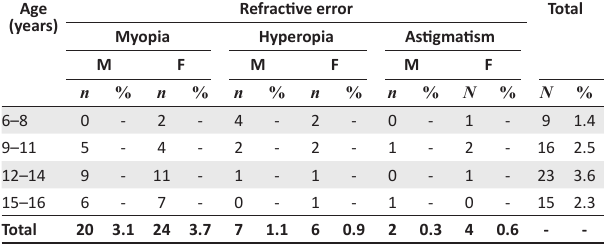
TABLE 2: Age distribution of refractive error amongst participants.